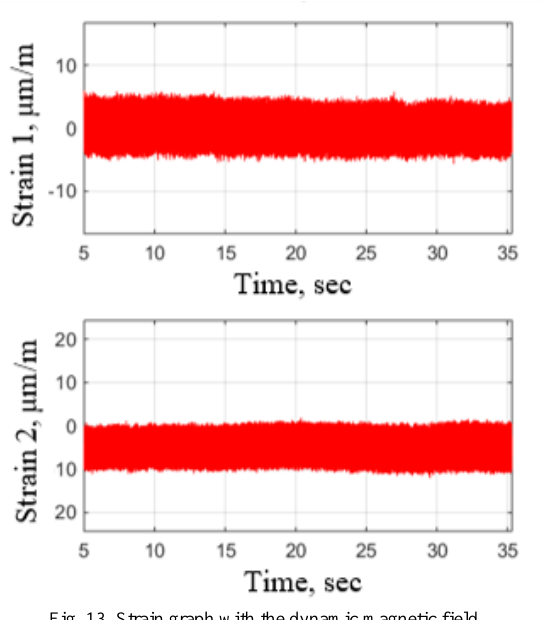
Fig. 13. Strain graph with the dynamic magnetic